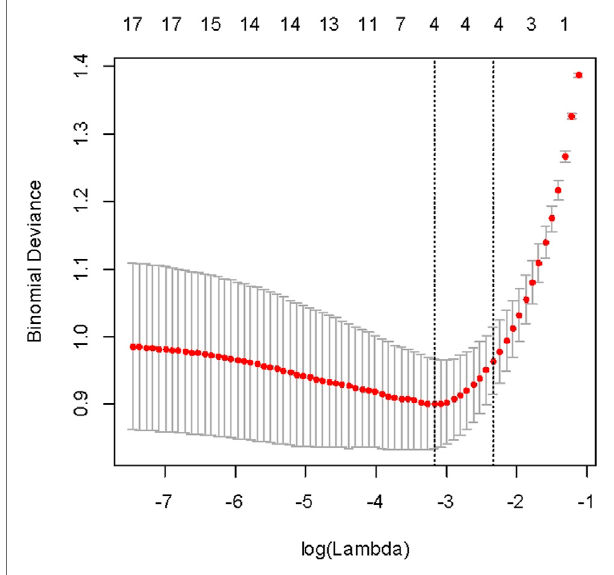
FIGURE 1 | Selecting lambda to screen characteristic